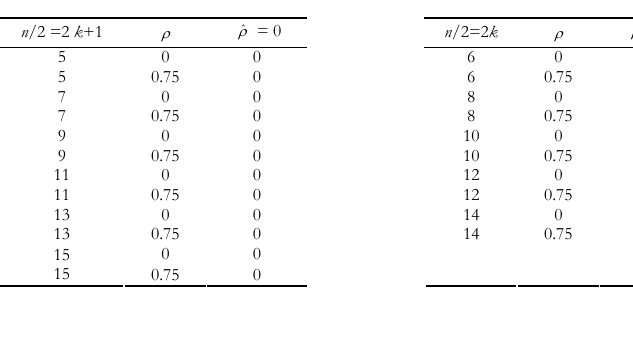
Simulations number with  ˆ = 0 for N = 1000 and n/2 = 5, 6, ..., 15